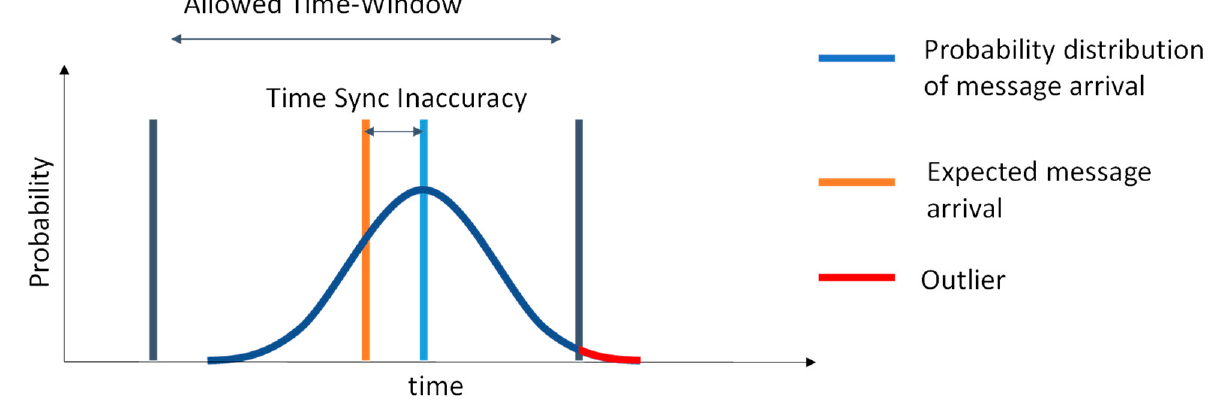
Figure 9. Arrival time window in the context of jitters and time synchronization.